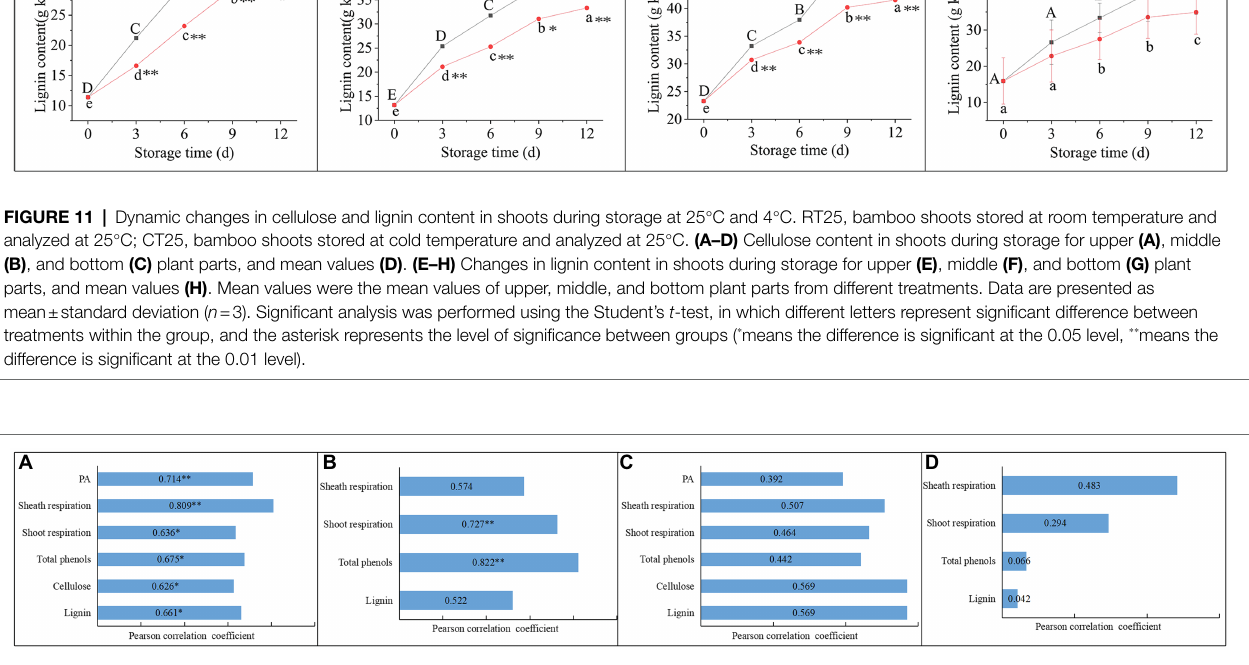
FIGURE 12 | Pearson correlation analysis between different physiological factors during shoot browning and the aging process. * indicates a significant correlation, and ** indicates an extremely significant respiration (A) Pearson correlation for NSC degradation between the dynamics of PA, cellulose, and lignin content and the dynamics of shoot and shoot respiration rates during storage at 25 ° C (B) Pearson correlation between PA content and the dynamics of lignin and total phenol contents and the dynamics of shoot and sheath respiration rates during storage at 25 ° C (C) Pearson correlation for NSC degradation between the dynamics of PA, cellulose, and lignin content and the dynamics of shoot and shoot respiration rates during storage at 4 ° C (D) Pearson correlation for PA content between the dynamics of lignin and total phenol content and the dynamics of shoot and sheath respiration rates during storage at 4 ° C.